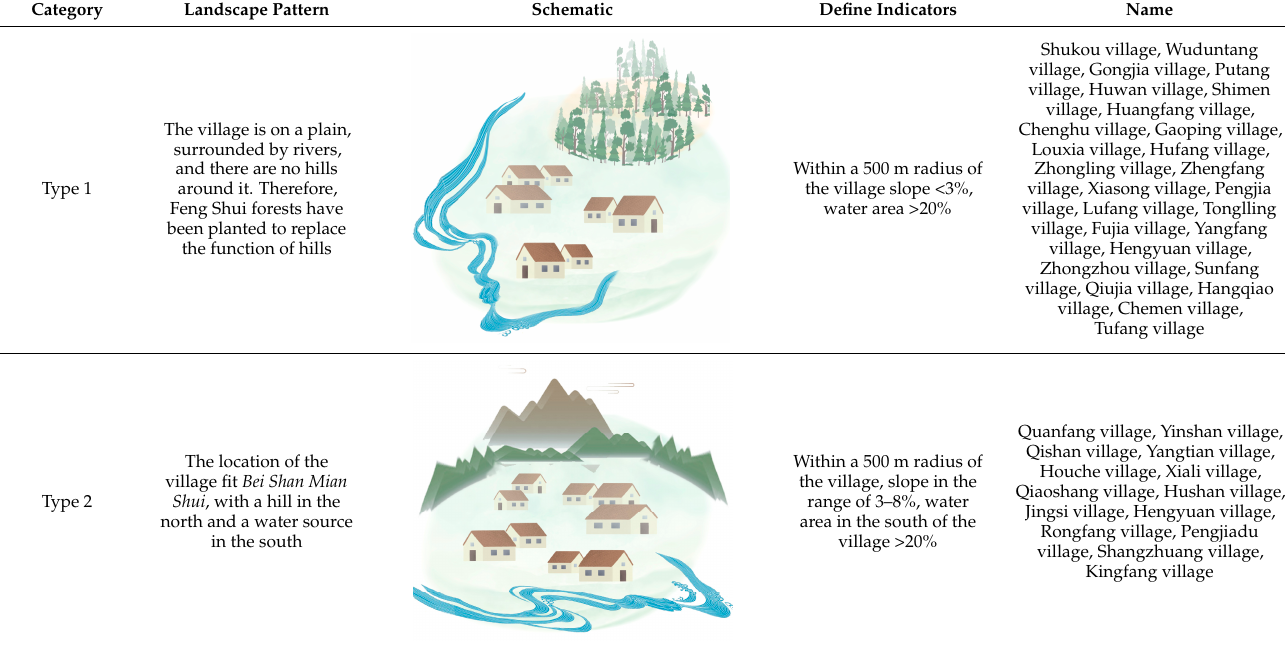
Figure 2. Distribution of 62 traditional villages in Jinxi County. Table 1. Classification of the landscape pattern of traditional villages in Jinxi County.